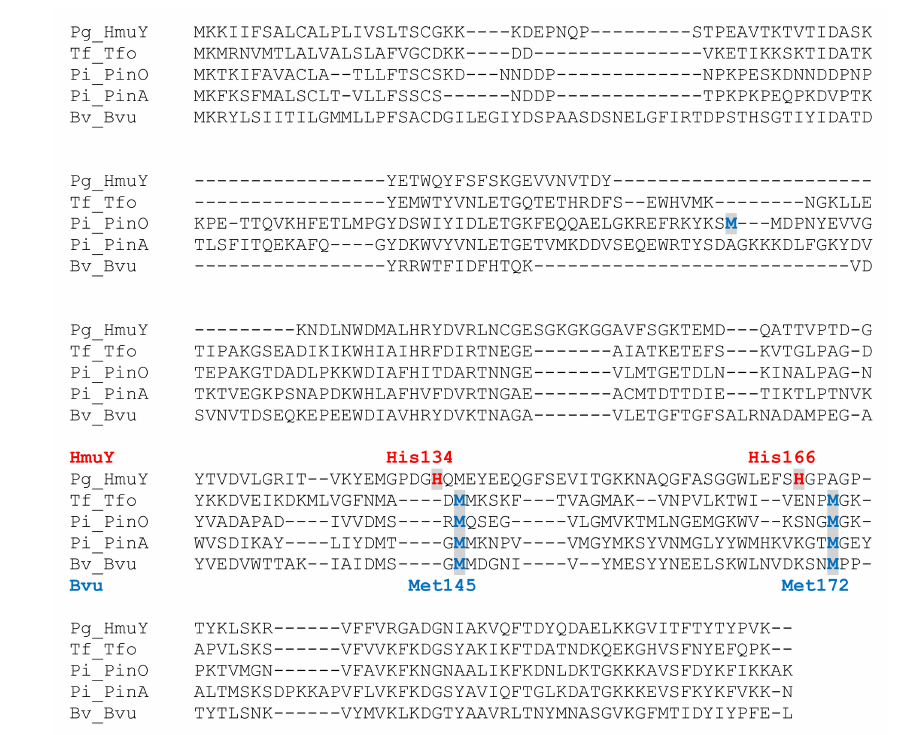
Figure 2. Amino acid sequence comparison of Bvu protein with the best characterized HmuY family members. Verified by mutagenesis and crystallization ( P. gingivalis HmuY) or examined by mutagenesis ( T. forsythia Tfo, P. intermedia PinO and PinA, B. vulgatus Bvu) heme iron-coordinating ligands are shown in grey boxes and marked in red (HmuY) or blue (HmuY